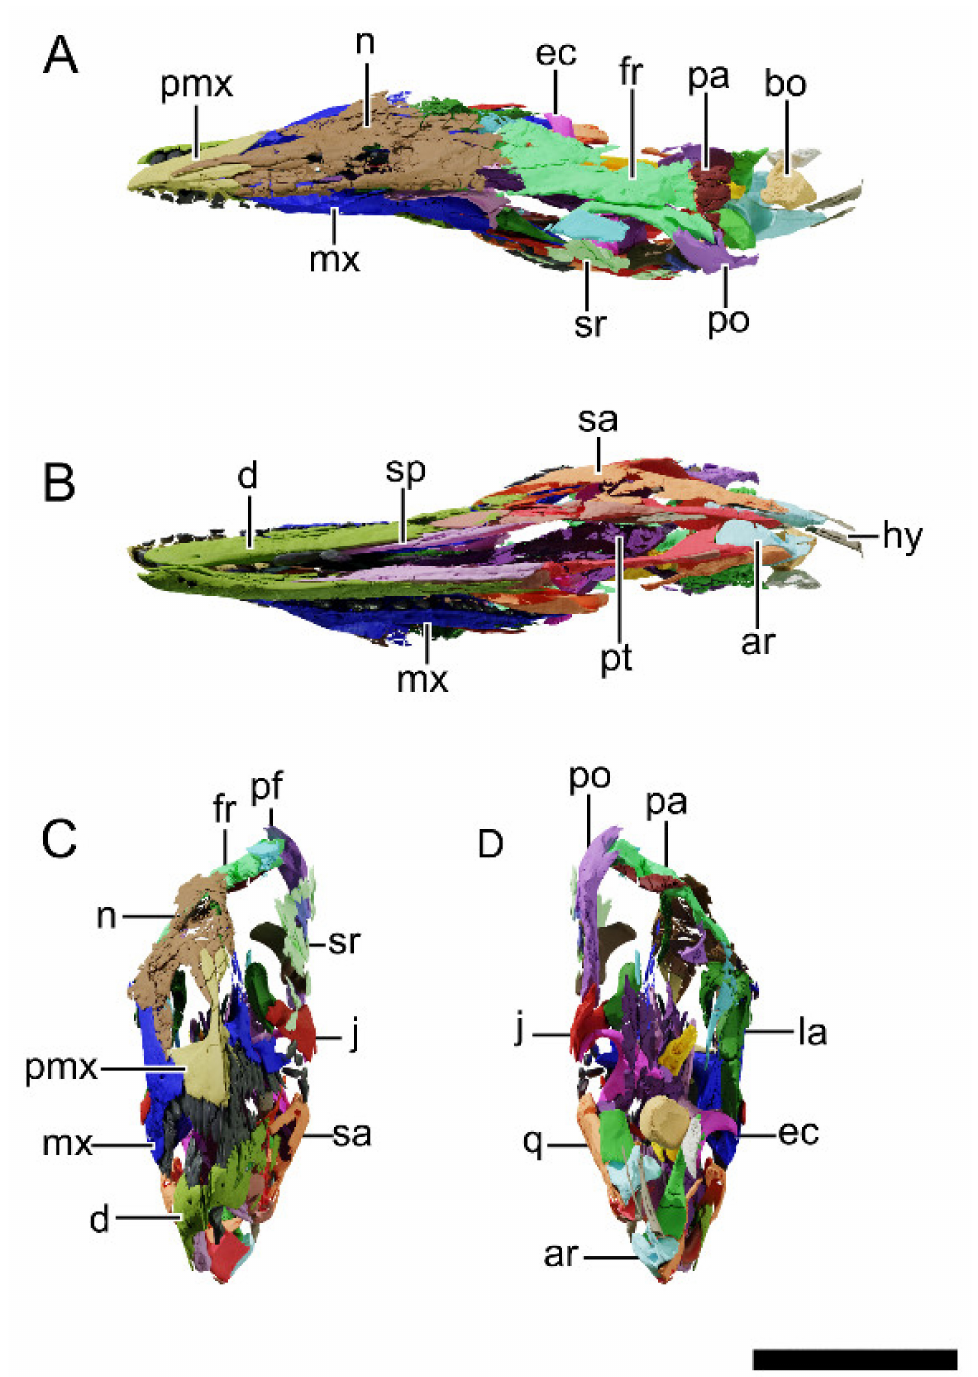
Figure 7. Digital reconstruction of the skull of NHMD 164758. ( A ) Dorsal view. ( B ) Ventral view. ( C ) Anterior view. ( D ) Posterior view. Abbreviations: ar, articular; bo, basioccipital; d, dentary; ec, ectopterygoid; fr, frontal; hy, hyoid; j, jugal; la, lacrimal; mx, maxilla; n, nasal; pa, parietal; pf, prefrontal; pmx, premaxilla; po, postorbital; pra, prearticular; pt, pterygoid; q, quadrate; sa, surangular; sp, splenial; sr, sclerotic ring. Scale bar = 50 mm.